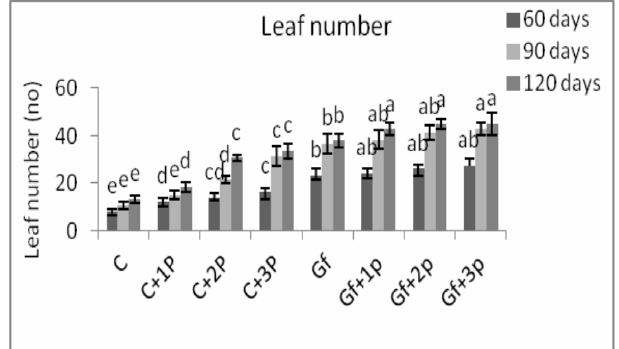
Fig. 3. Number of leaves in Catharanthus roseus inoculated with Glomus fasciculatum after 60, 90 and 120 days of AM